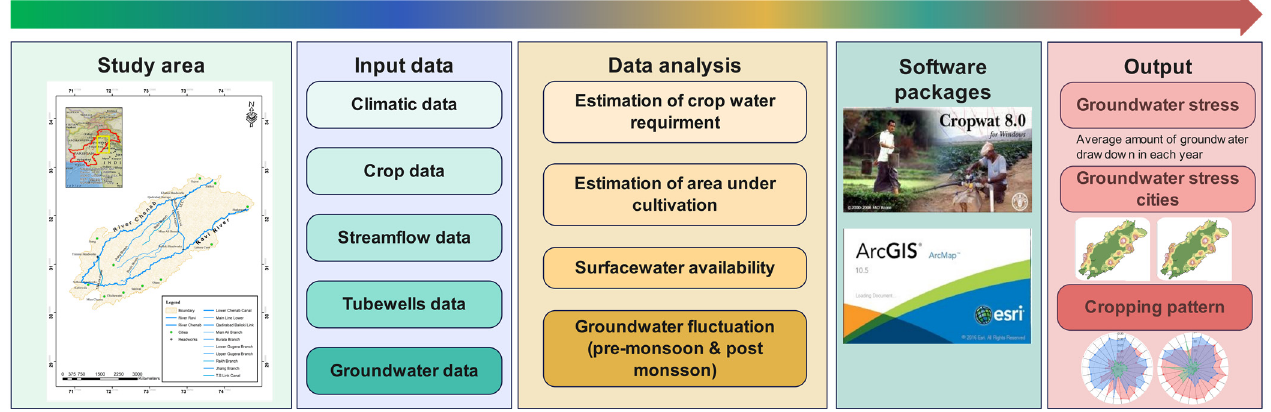
Figure 2. A detailed flow chart of the methodology adopted in the study.